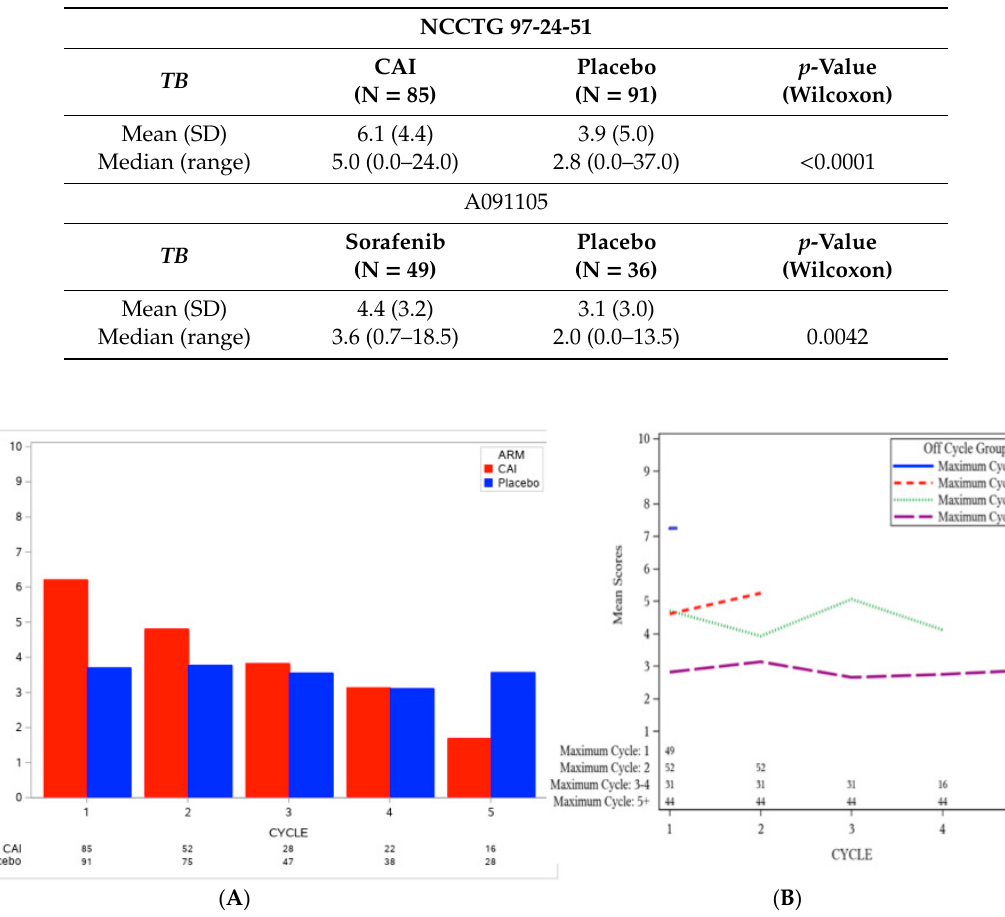
Figure 1. ( A ) AE burden by treatment cycle, B(t) , grouped by treatment arm; ( B ) AE burden by treatment cycle, B(t) , (across treatment arms) grouped by the last administered cycle for NCCTG 97- 24-51.